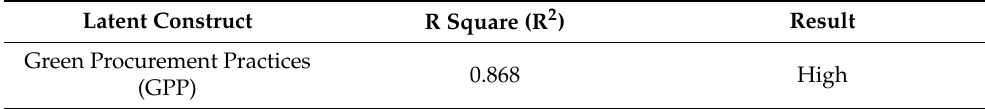
Table 7. R-square of endogenous